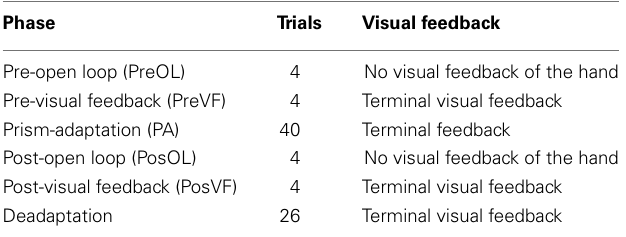
Table 1 | Phase order and number of trials per phase with visual feedback conditions.